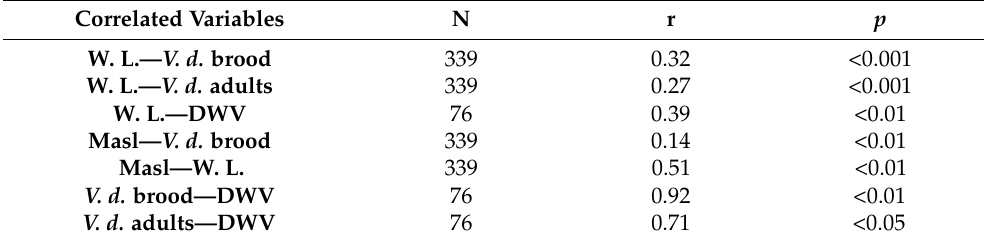
Table 2. Correlations of worker forewing length (W. L.) and altitude above sea level (masl) with parasitism intensity by Varroa destructor ( V. d. ), or infection intensity by deformed wing virus (DWV). Only significant ( p < 0.05) correlations are shown. Correlated